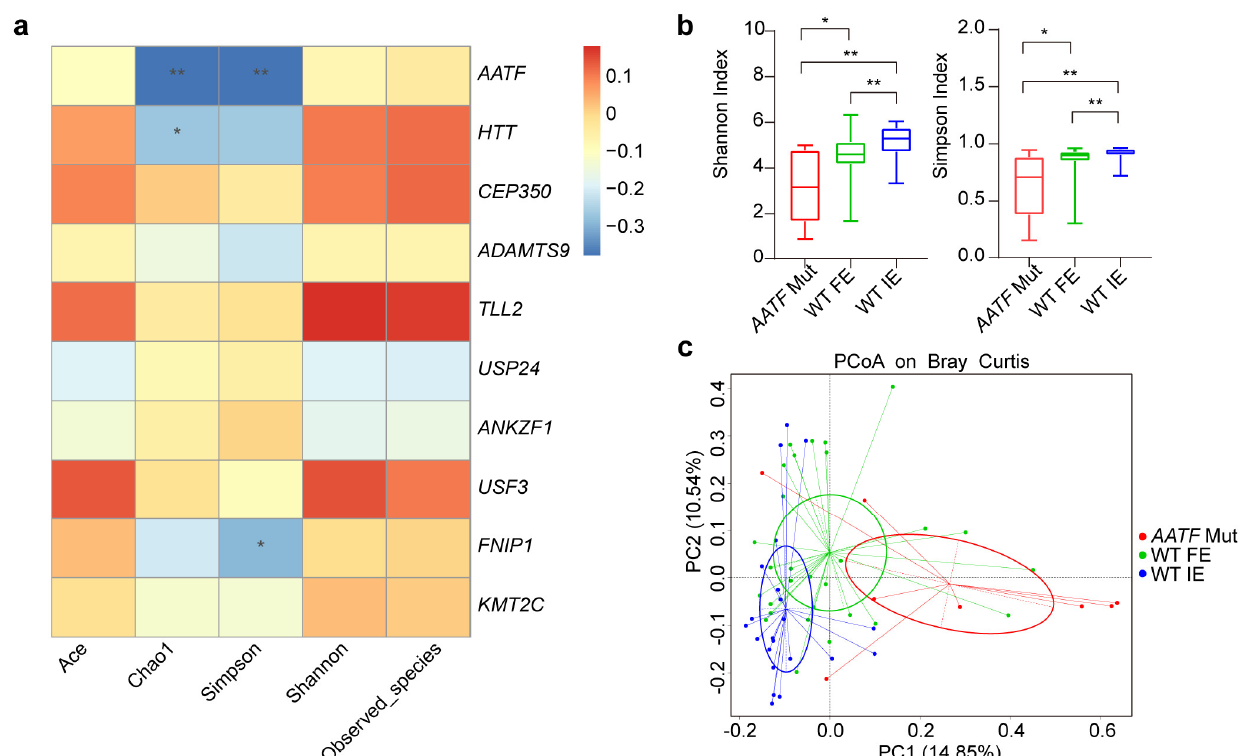
Figure 4. ( a ) Heatmap of Spearman correlation analysis between the relative abundances of sputum microbiome and alpha diversity indices. Significant association (| r | > 0.3, p < 0.01) were shown between Chao1 index and Simpson index in AATF gene. ( b ) Comparison of alpha diversity indices (Shannon index, Simpson’s index) of AATF Mut (n = 9), WT FE (n = 28), and WT IE (n = 22) by